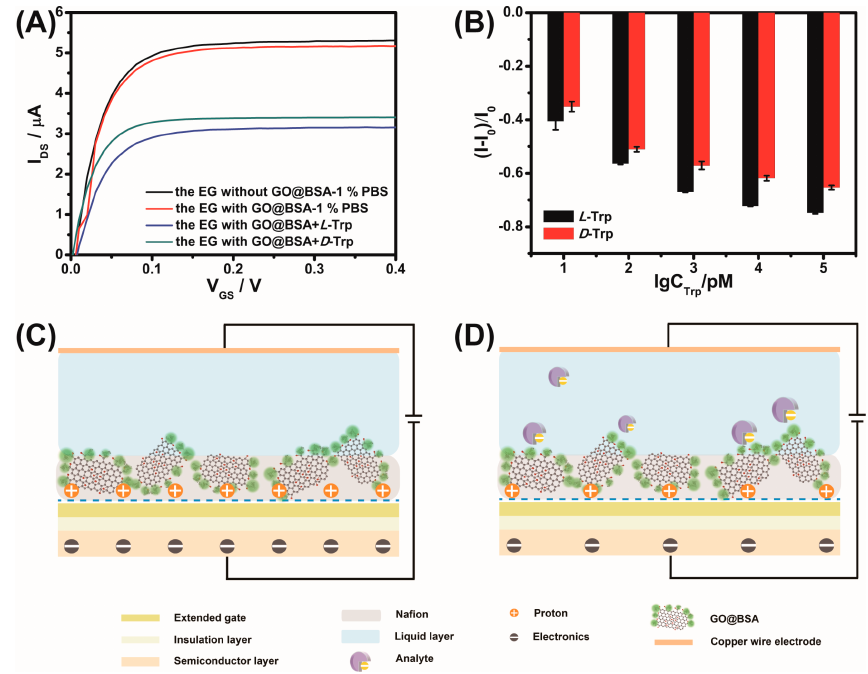
Figure 10. Non-real-time detection of Trp by Nafion–GO@BSA–EG-MOSFET ( A , B ) and schematic illustration of chiral recognition mechanism ( C , D ).